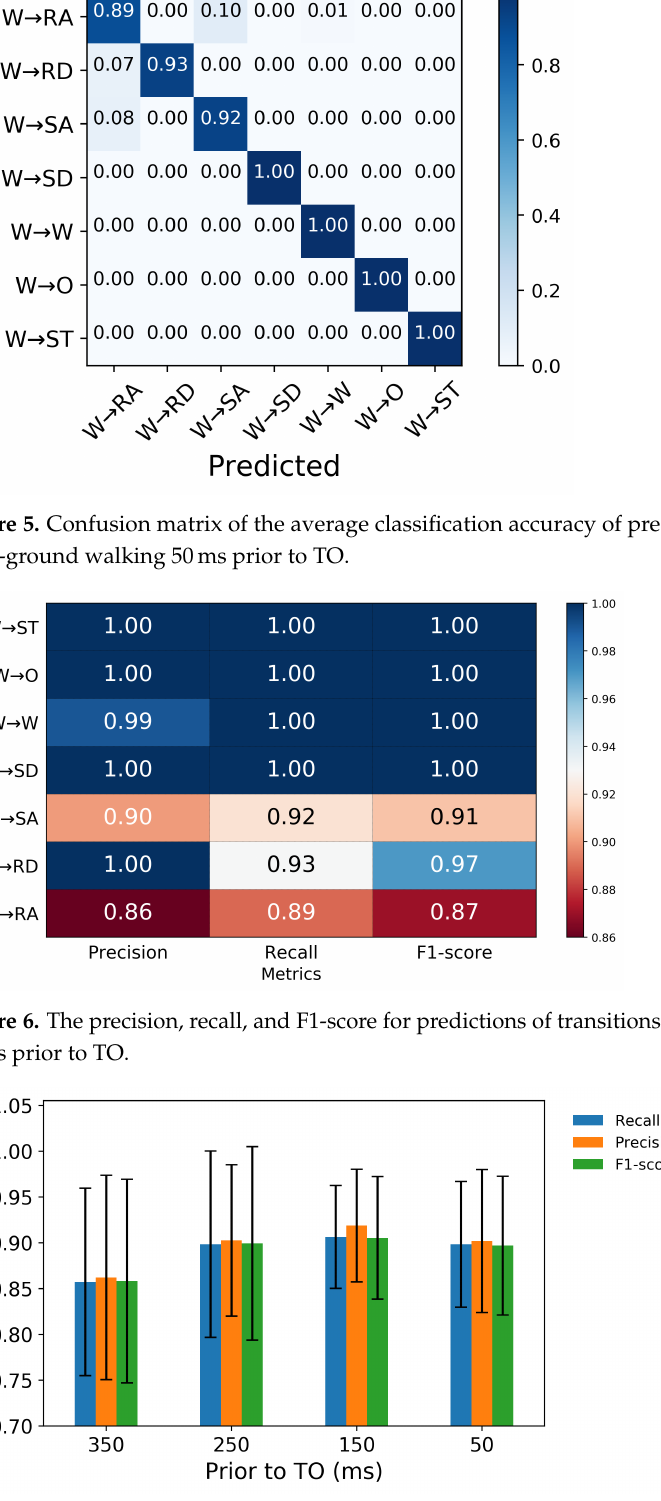
Figure 7. The precision, recall, and F1-score for predictions of transitions from ramp ascent 350, 250, 150, and 50ms prior to